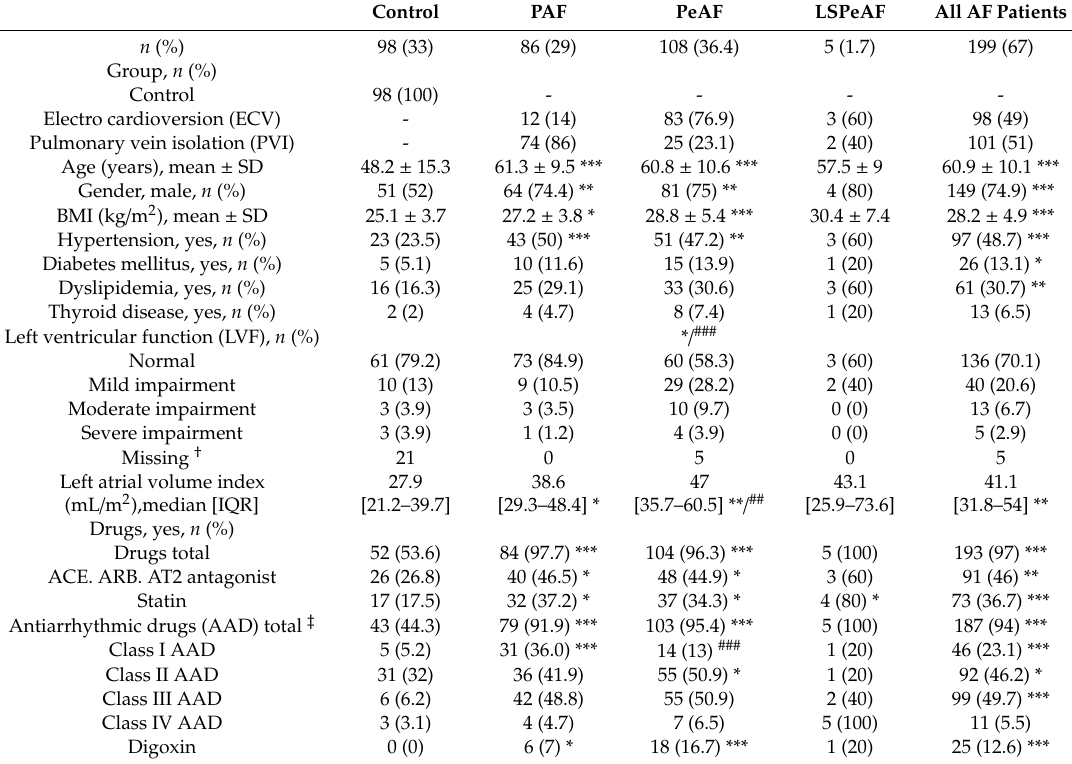
Table 1. Clinical characteristics of the study